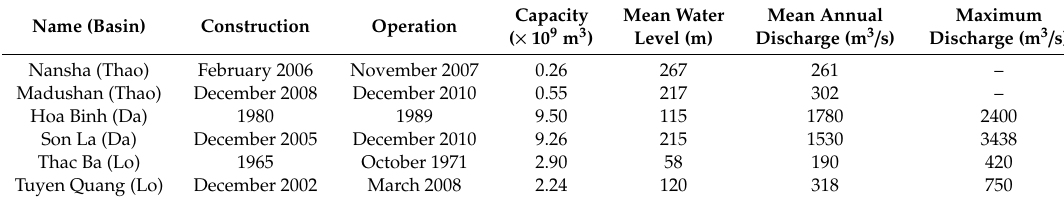
Table 1. Basic Characteristics of the Dams